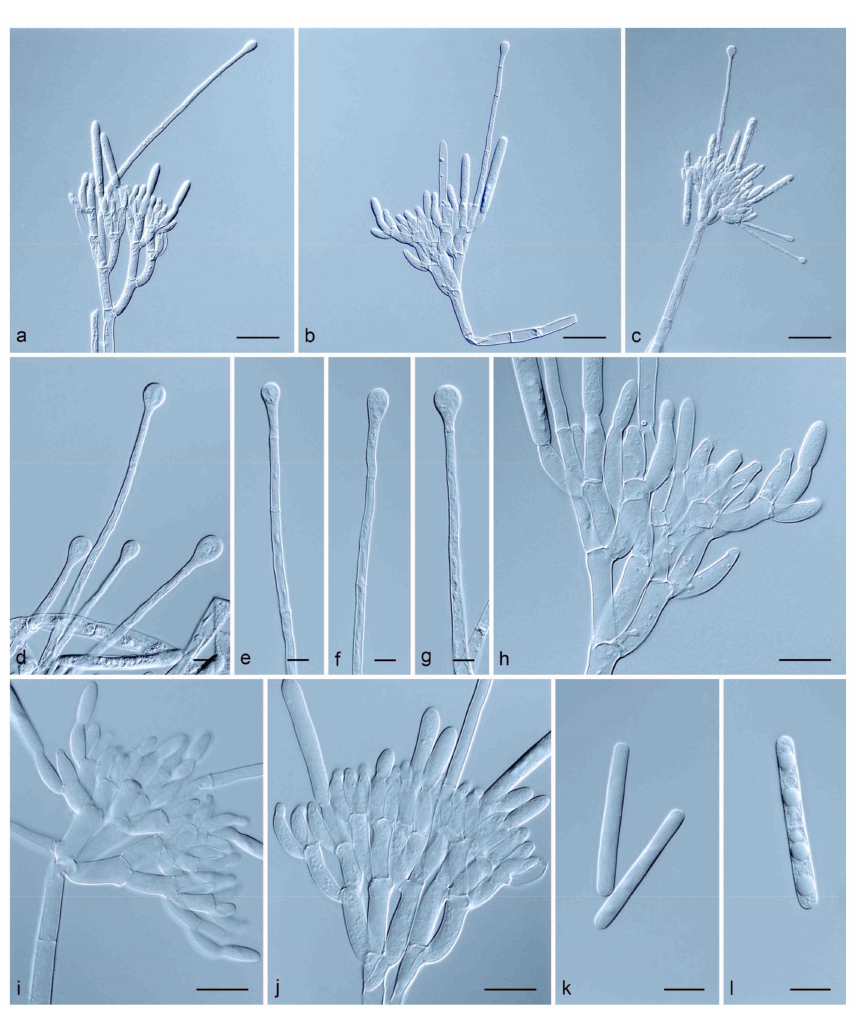
Figure A11. Calonectria pacifica . ( a – c ). Macroconidiophore; ( d – g ). ovoid to